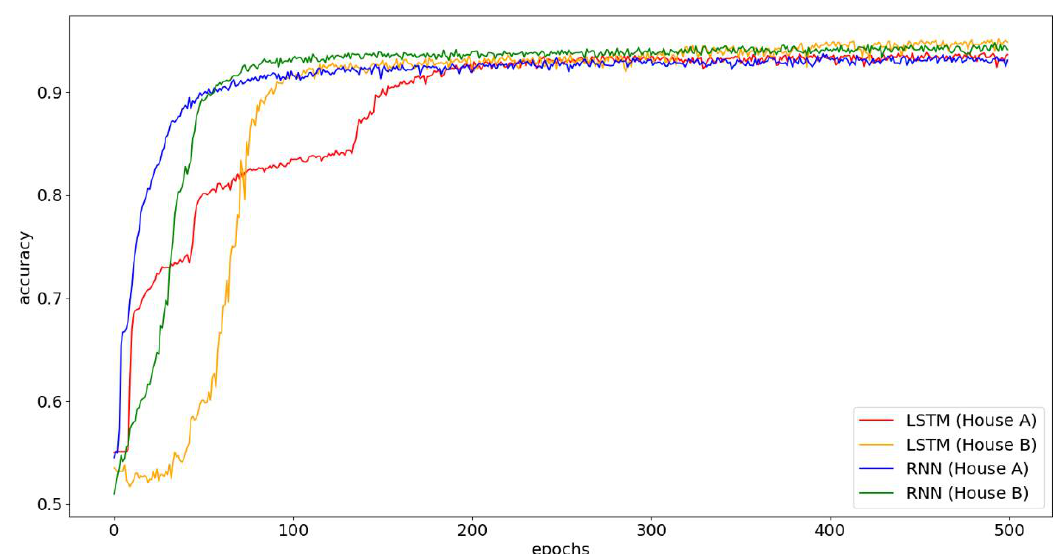
Figure 11. Convergence graph of RNN and LSTM.